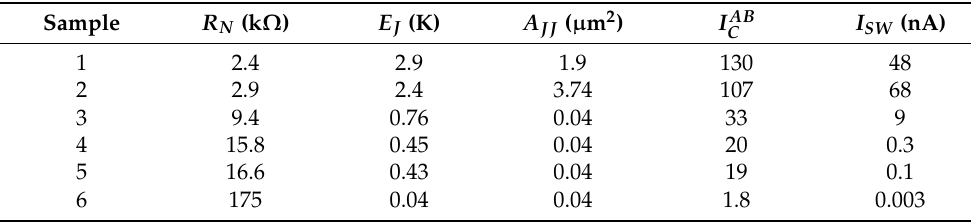
Table 1. Parameters of single Josephson junctions in SQUID chains. R N and A JJ are the normal-state resistance and the junction area, respectively. The Josephson energy E J = π ¯ h ∆ / (( 2 e ) 2 R N ) has been calculated using R N and T C = 1.3 K . The charging energy E C , where C is the shunting capacitance, did not exceed 10 mK for all samples. The critical current I AB was calculated using Equation C